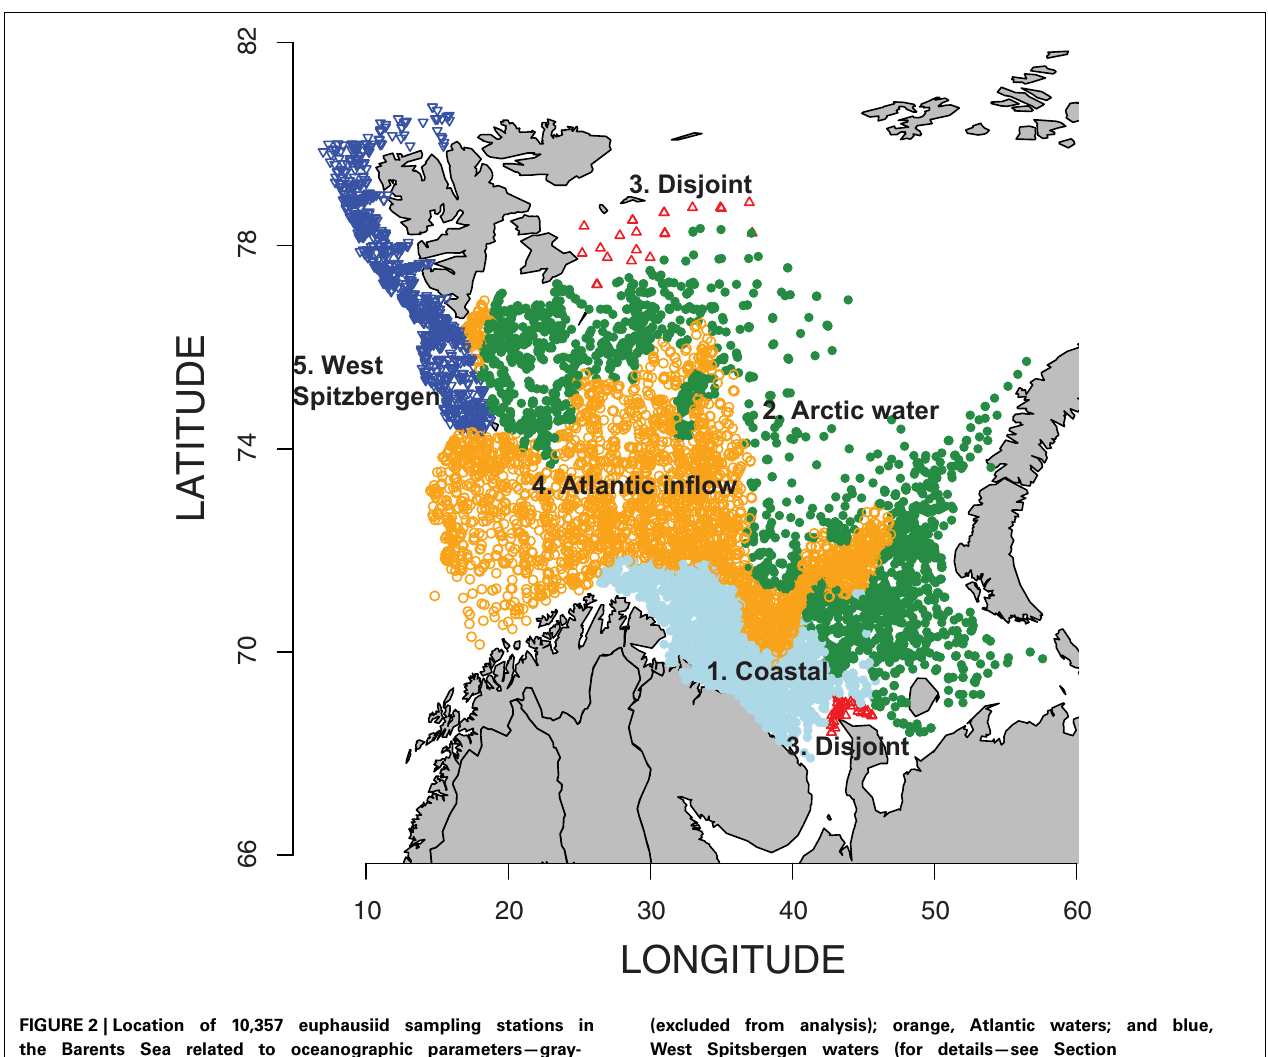
(excluded from analysis); orange, Atlantic waters; and blue, West Spitsbergen waters (for details—see Section “Results”).